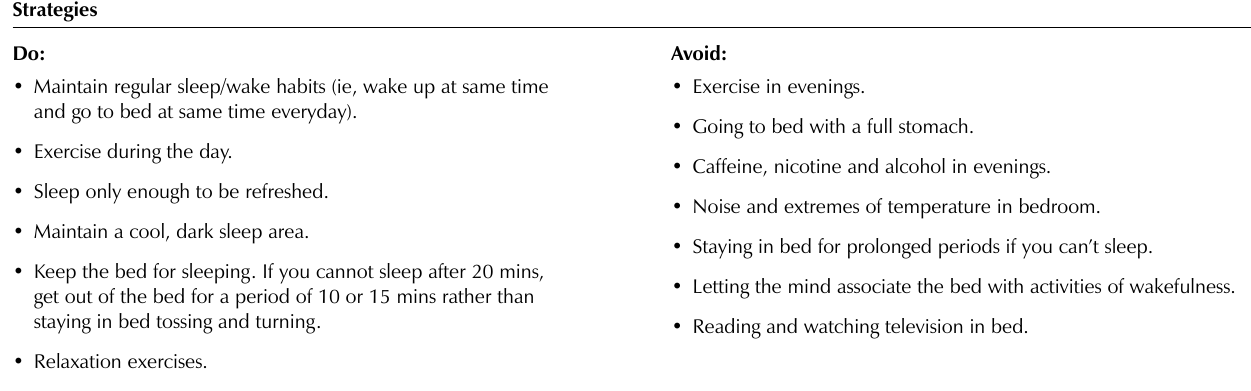
Adapted from reference